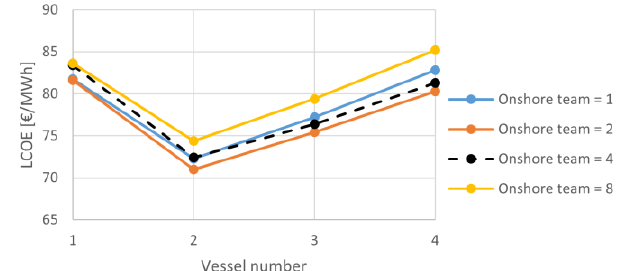
Fig. 27. LCOE versus vessel number for various numbers of onshore teams, in the case of c/d time=2 hr and assembly team=3.